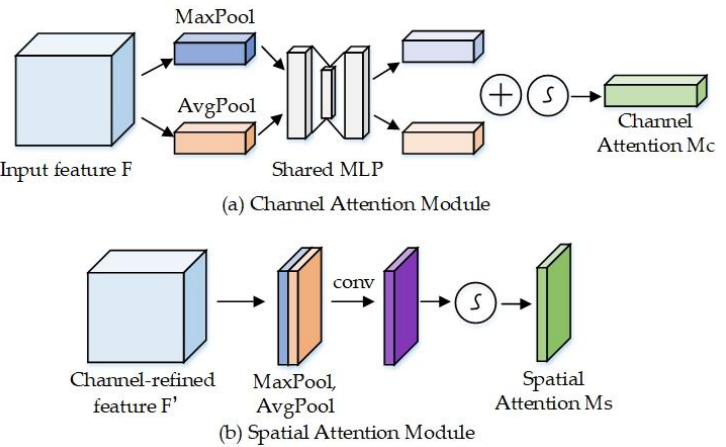
Figure 8. Structure of the CBAM attention module. ( a ) Structure of the Channel Attention Module; ( b ) Structure of the Spatial Attention Module.